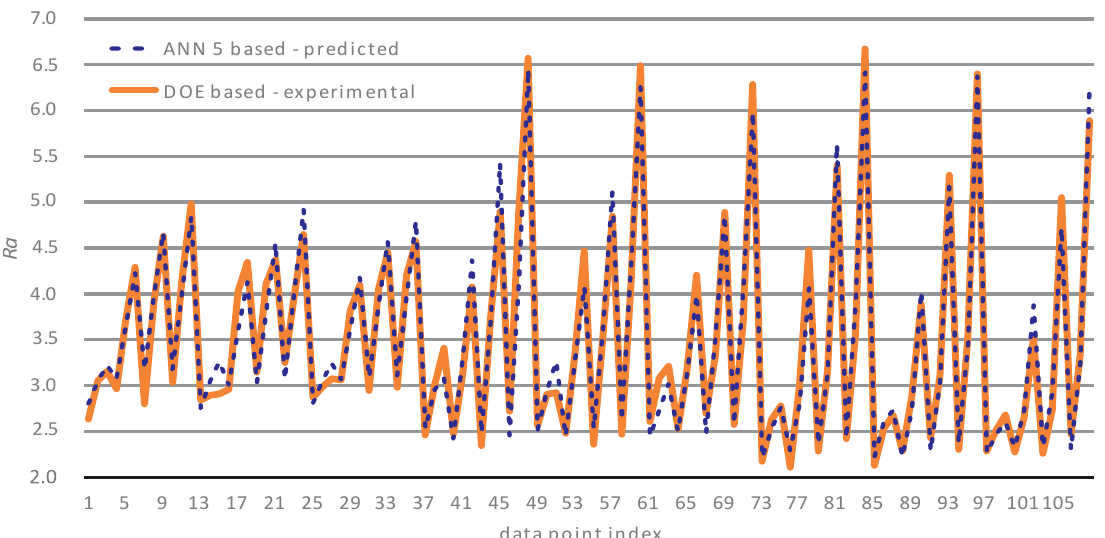
Figure 6. Experimental surface roughness vs. predicted surface roughness of the training data.